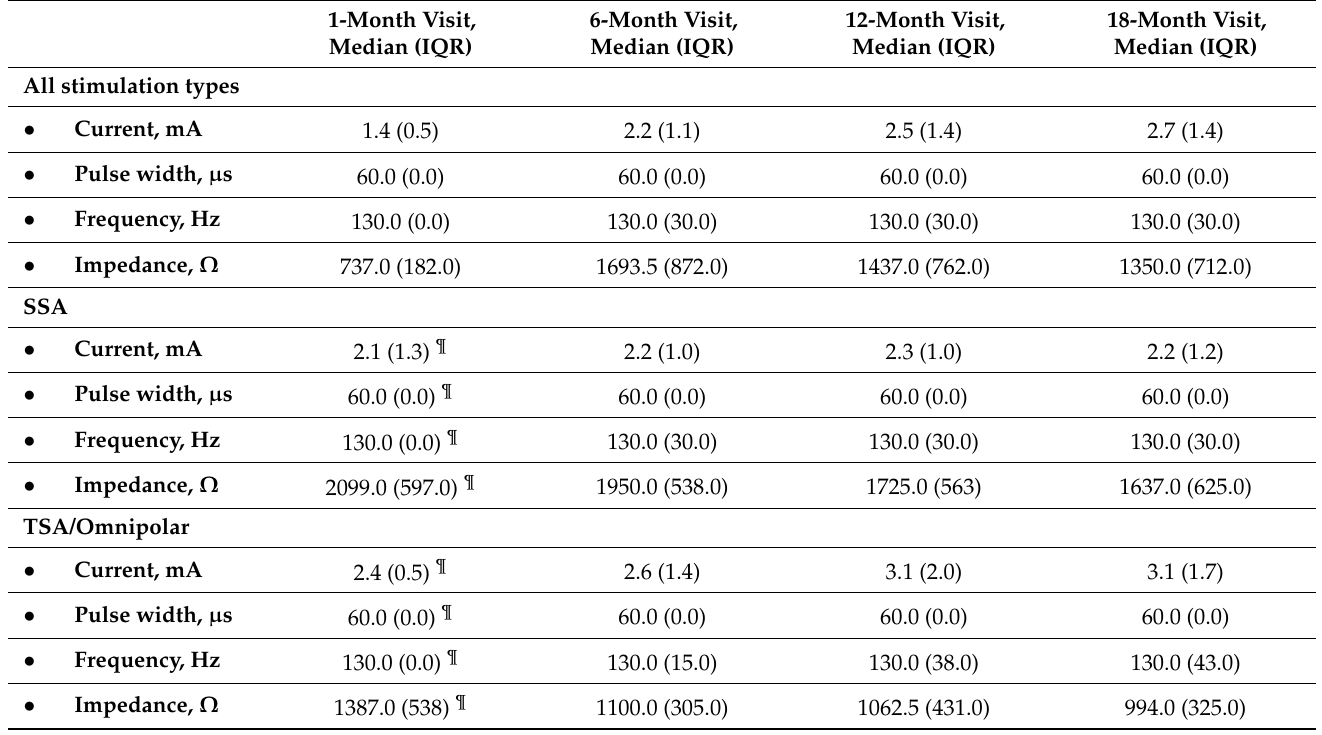
Table 3. DBS settings during the